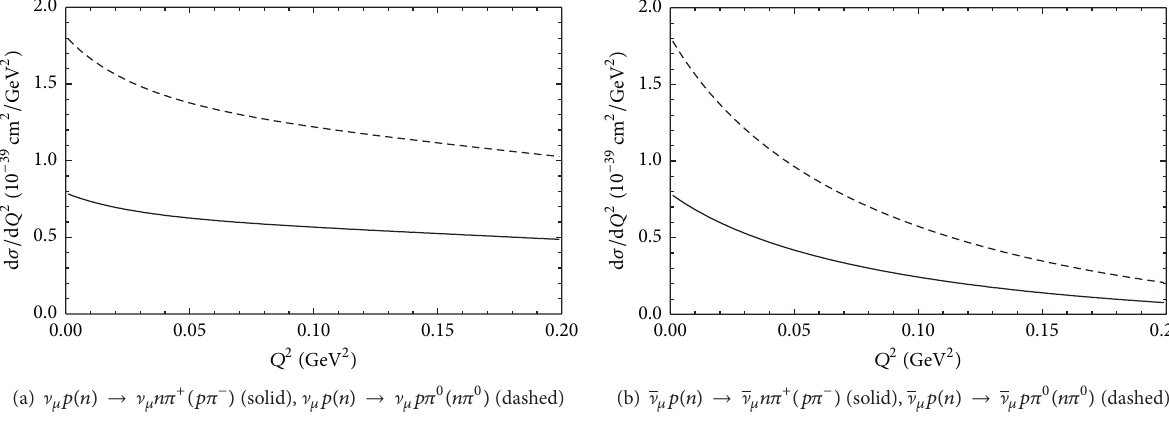
Figure 4: Neutral current reactions at 𝐸 ] = 1